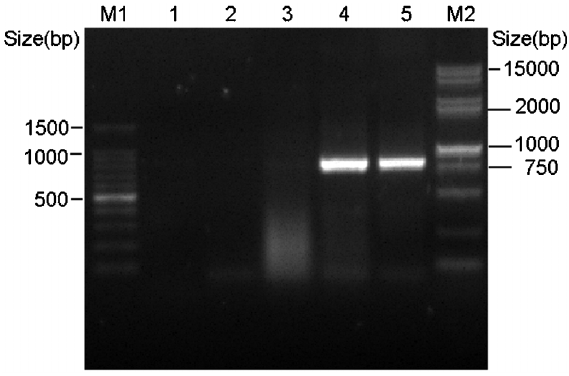
Figure 3. Expression of pcDNA3- mIL-33 in mouse hepatocytes. Total RNA was extracted from mouse hepatocytes 8 h after transfection with pcDNA3- mIL-33 using the hydrodynamics- based transfection method. The templates used for RT-PCR were as follows: lane 1 , distilled water as a negative control; lane 2 , cDNA from hepatocytes of mouse transfected with pcDNA3 as a negative control; lane 3 , RNA from hepatocytes of mouse transfected with pcDNA3- mIL-33 as a negative control; lane 4 , cDNA from hepatocytes of mouse transfected with pcDNA3- mIL- 33 ; lane 5 , pcDNA3- mIL-33 plasmid served as a positive template. M1: 1500 bp DNA marker; M2: DL15,000++2000 bp DNA